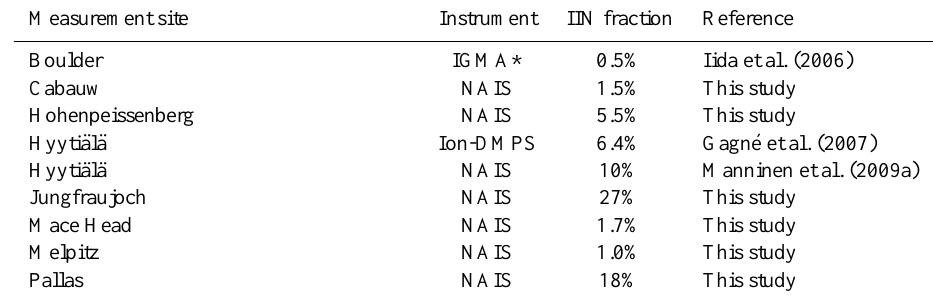
Table 4. The observed fraction of ion-induced nucleation (IIN) from total particle formation in various environments. The fraction reported by Manninen et al. (2009a) includes also the contribution of ion-ion recombination to IIN.